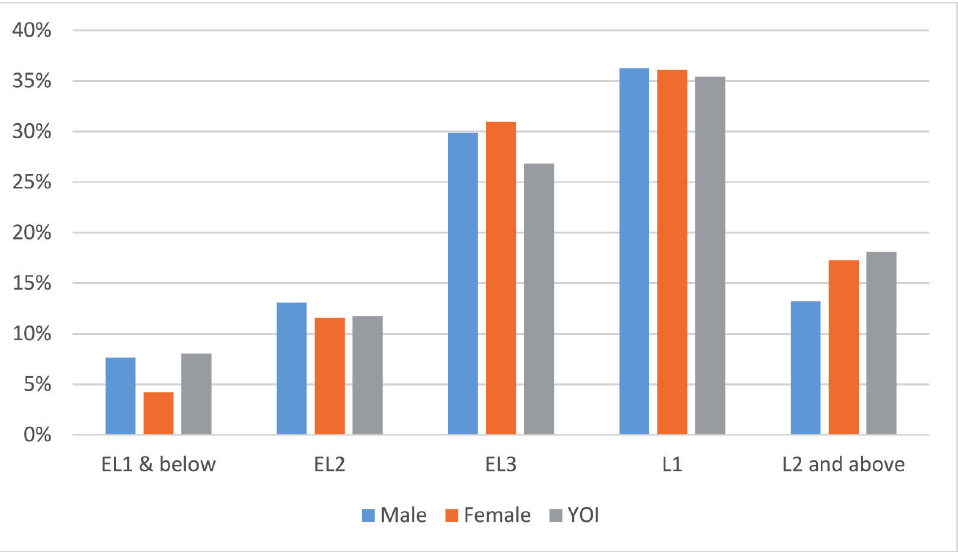
Figure 3: Prisoners’literacylevelsbygender